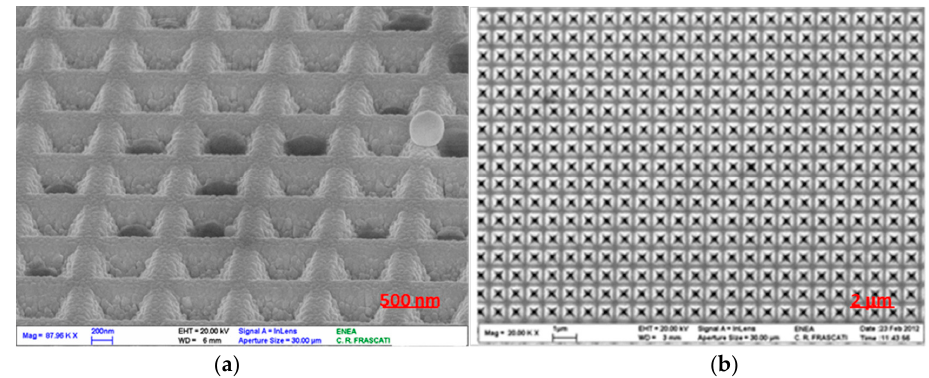
Figure 2. SEM images of two distinct areas of the same SERS substrate: ( a ) the inverted pyramidal pits randomly filled with the residual explosive (in this picture RDX); ( b ) a region out of the deposited drop showing each pyramidal pit empty.